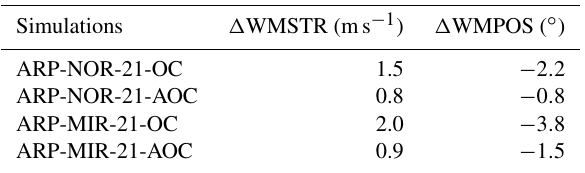
Table 5. Anomalies in southern westerlies maximum strength ( (cid:49) WMSTR, ms − 1 ) and position ( (cid:49) WMPOS, ◦ ) for the different ARPEGE